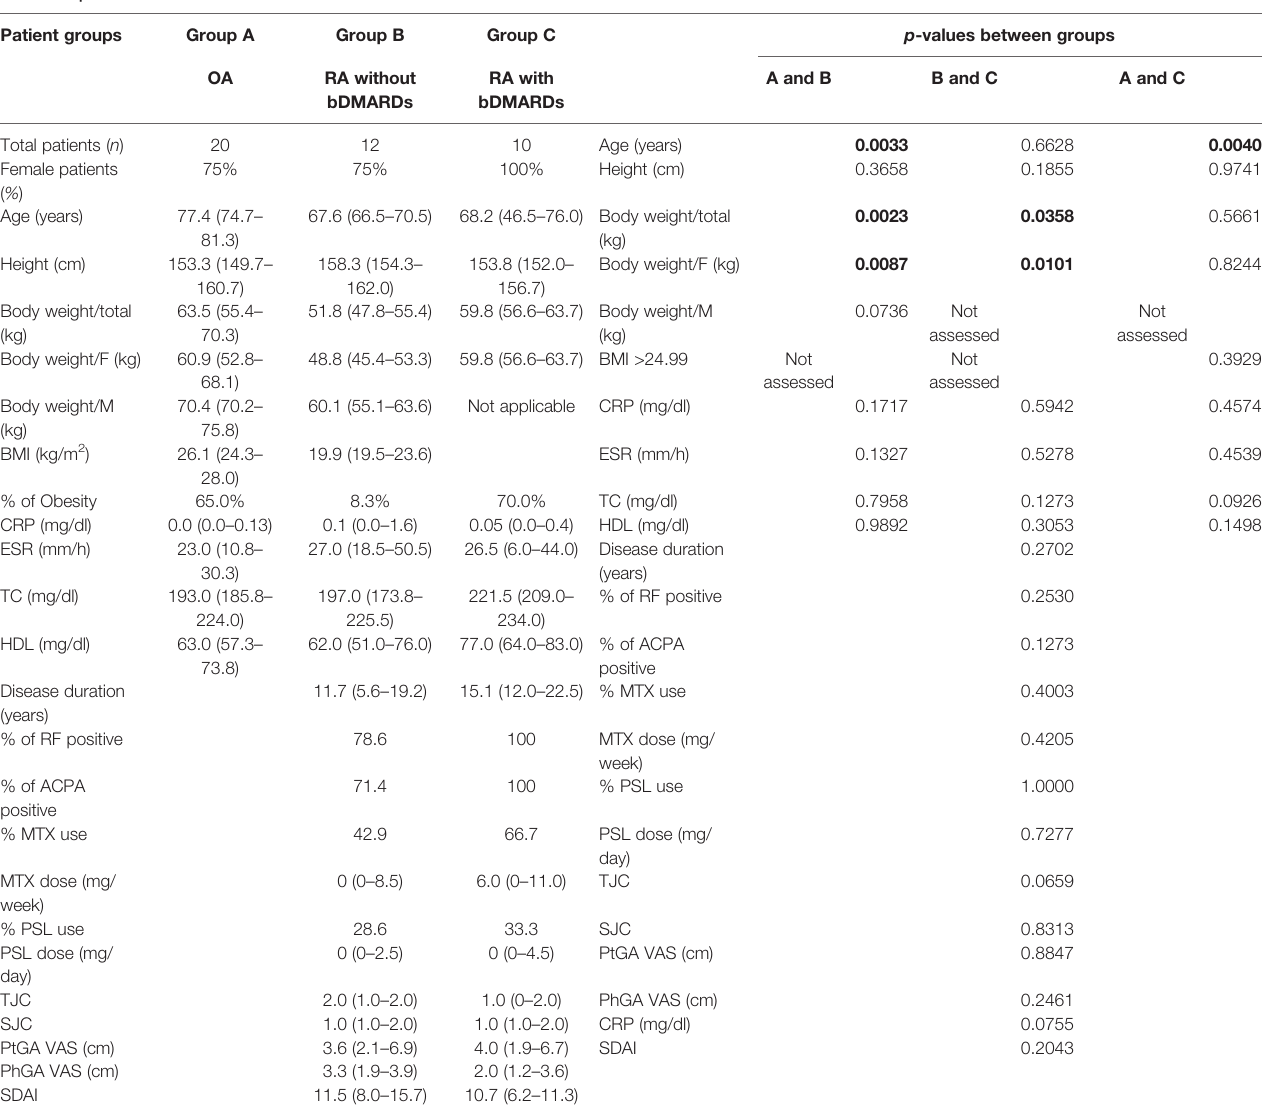
TABLE 1 | Patient